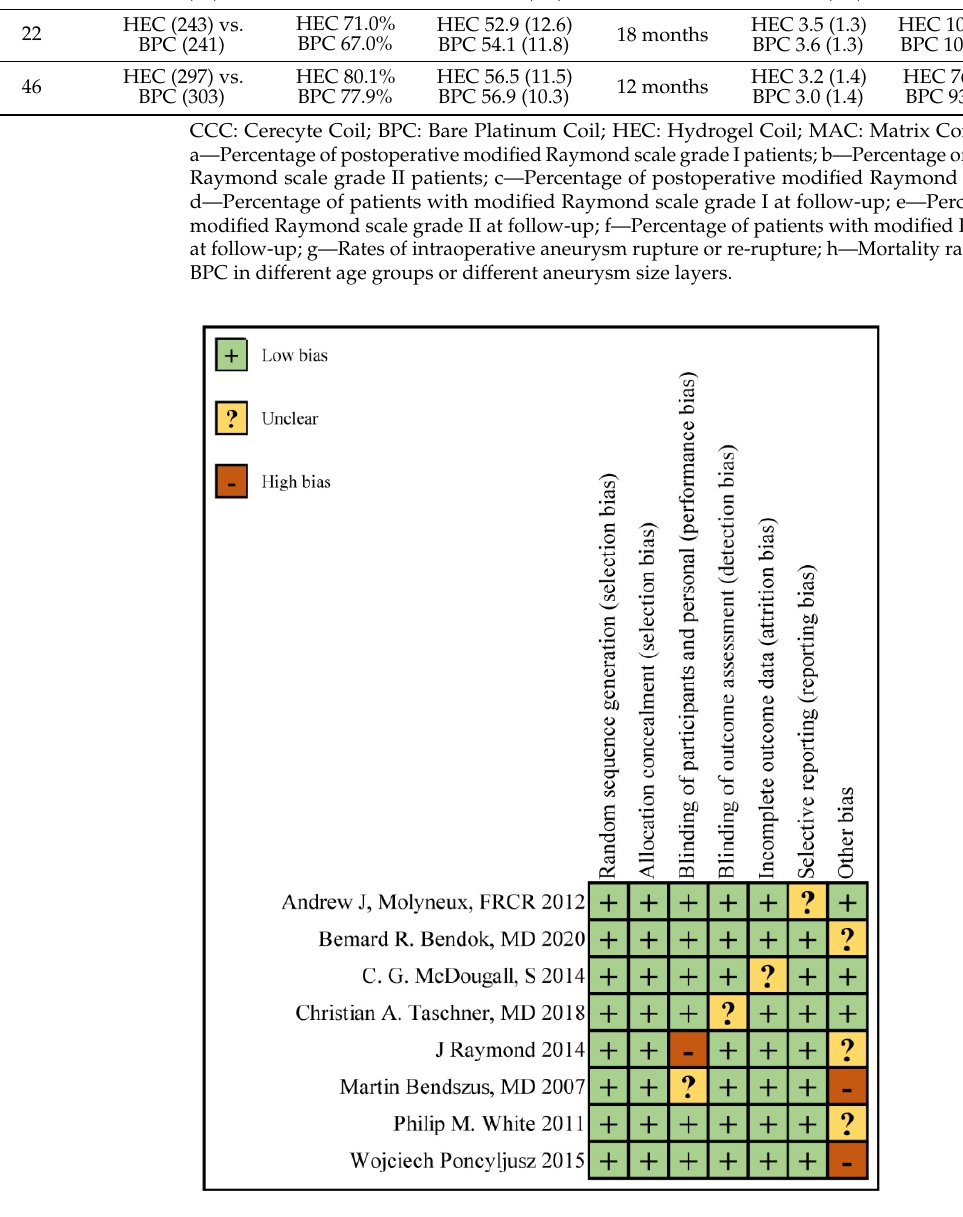
Figure 2. Risk of bias summary: review of authors’ judgements about each risk of bias item for each included